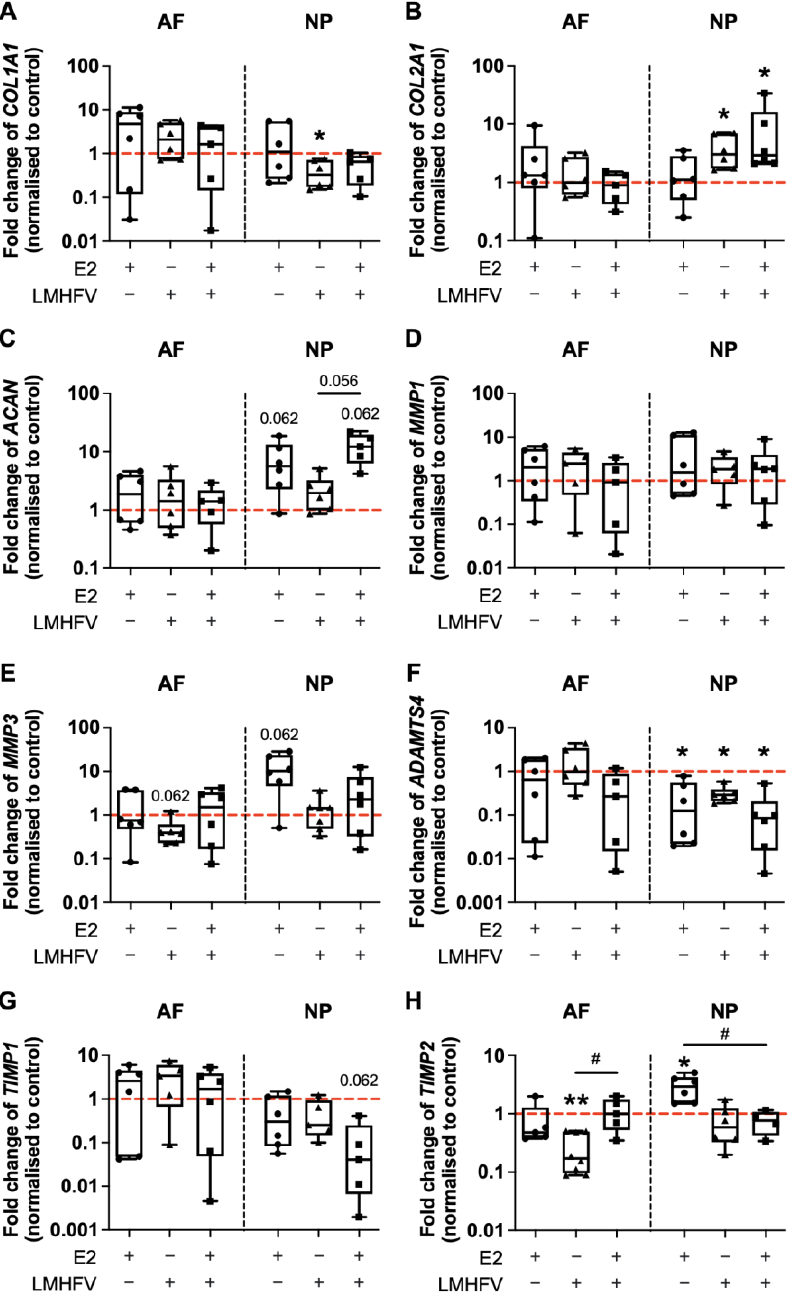
Figure 3. Relative gene expression of IVD matrix components ( A ) COL1A1 , ( B ) COL2A1 and ( C ) ACAN , matrix-degrading enzymes ( D ) MMP1 , ( E ) MMP3 and ( F ) ADAMTS4 and inhibitors of matrix degradation ( G ) TIMP1 and ( H ) TIMP2 in cells of the AF and NP. RNA was isolated at day 8 of organ culture. IVD groups were either cultured under basal conditions (control) or treated with oe- strogen (E2), low-magnitude high-frequency vibration (LMHFV) or the combination of E2 + LMHFV. Levels of mRNA were normalised to GAPDH and to the control ( red dashed line = 1). Results are presented as 2 − ∆∆ Ct in box plots ( n = 4–6 IVDs/group). * p < 0.05, ** p < 0.01 (*, comparison to the control); # p < 0.05 ( # , comparison to E2 + LMHFV